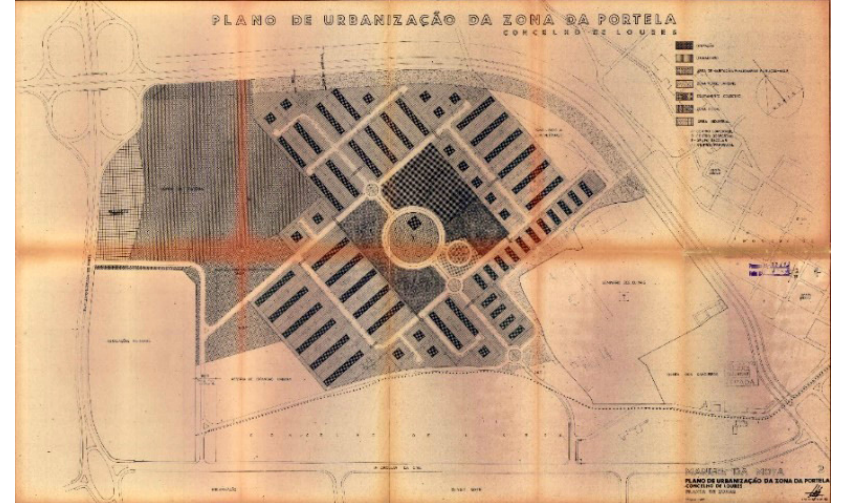
Figure 5. Urbanisation plan of Portela Zone (drawing). Source: Silva (1969). the centralised orientation of the urbanisation but also by the abstract and pragmatic nature of the architecture itself (Figure 6).